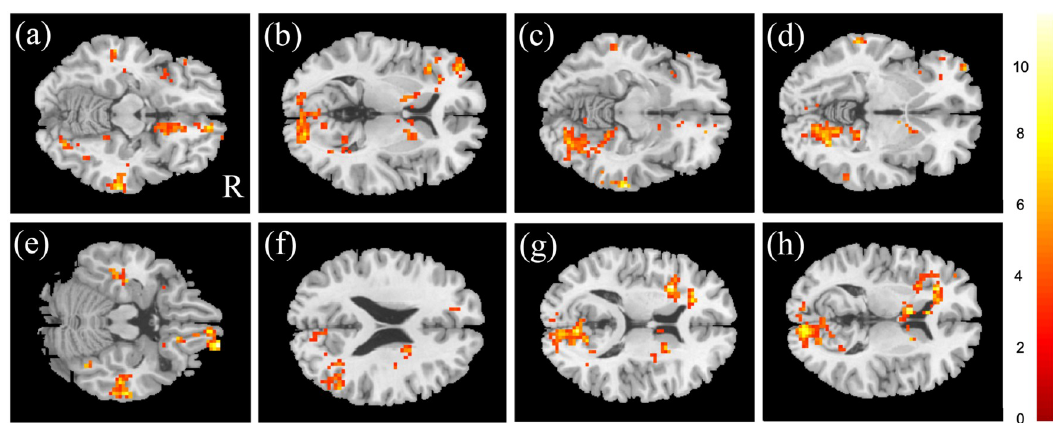
Fig 1. ANCOVA results of mfALFF in all three groups. Significant results were noted the (a) right superior frontal orbital gyrus, (b) left middle frontal gyrus, (c) right middle temporal gyrus, (d) left middle temporal gyrus, (e) right inferior temporal gyrus, (f) right angular gyrus, (g) left insula, and (h) left caudate (cluster size > 50, corrected p < 0.05, color bar, F scores).